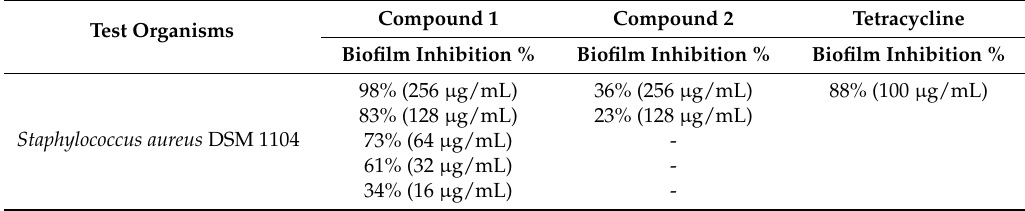
Table 3. Biofilm inhibitory activity of compounds 1 and 2